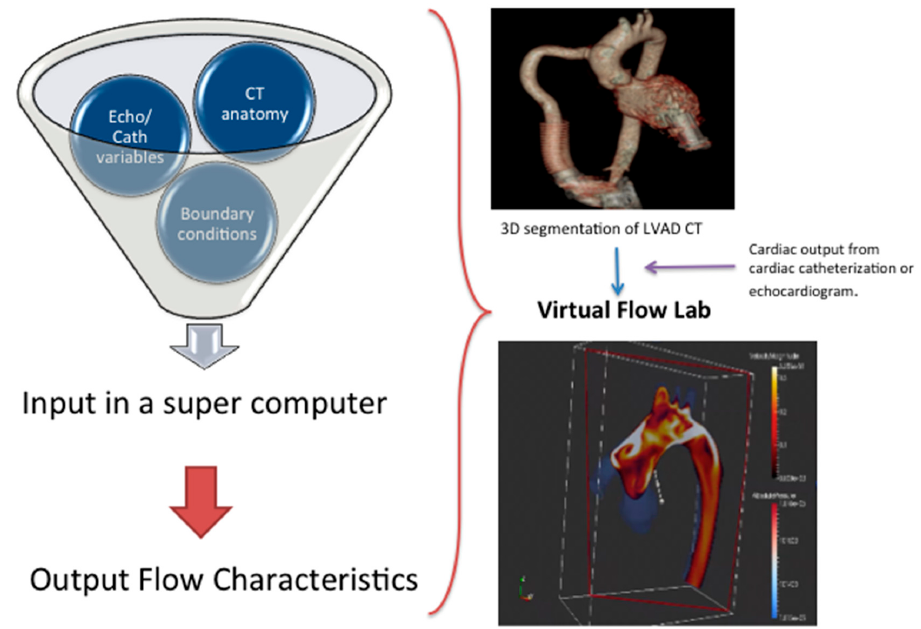
Figure 2. The workflow for computational fluid dynamics (CFD) analysis in a patient with LVAD. J. Clin. Med. 2019 , 8 , x FOR PEER REVIEW